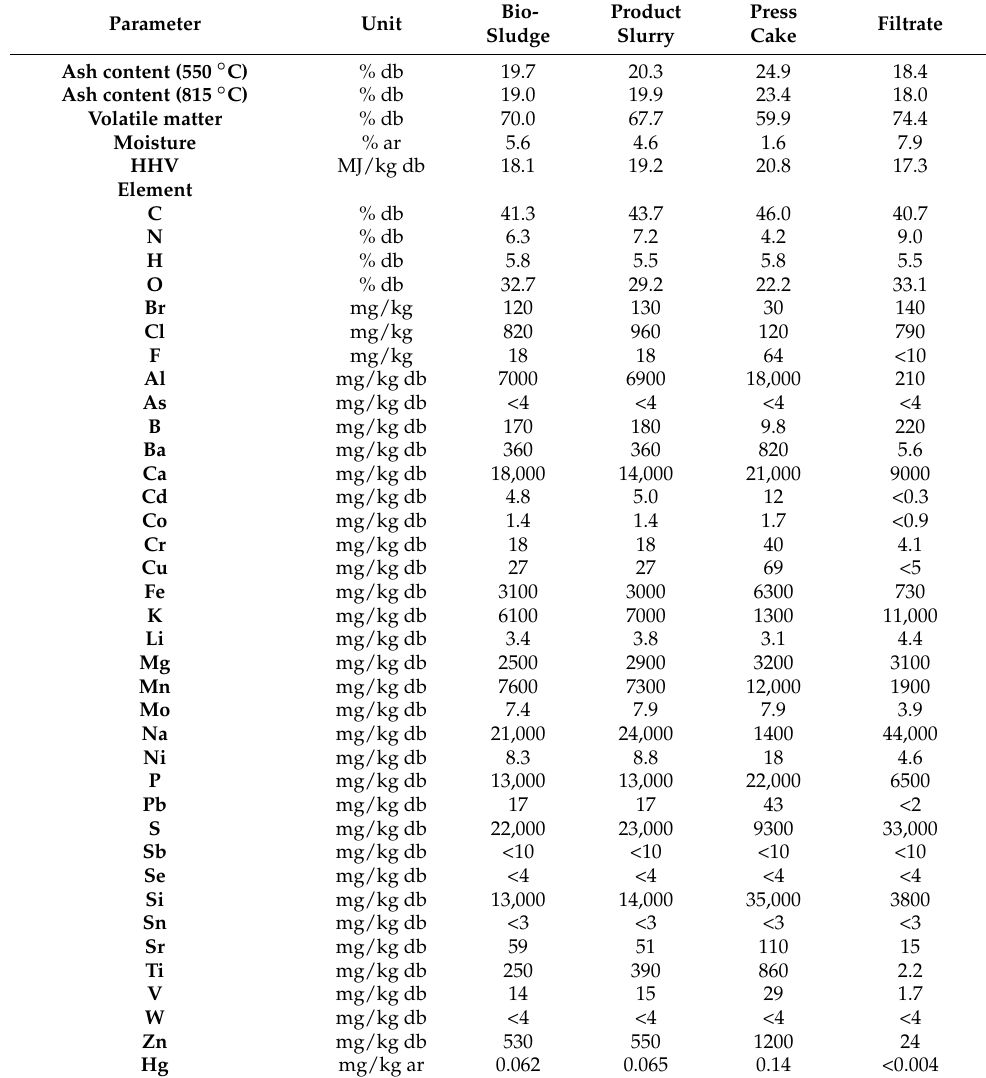
Table 7. Analysis results of bio-sludge, the hydrothermal carbonization product slurry, the press cake obtained with the membrane press and the resulting